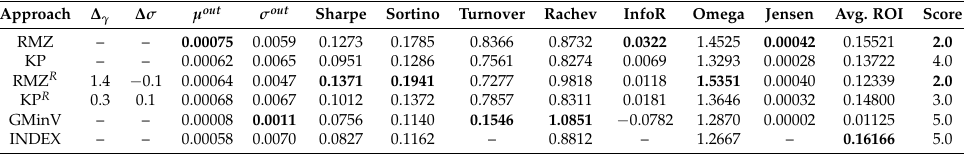
Table 10. Summary of results for